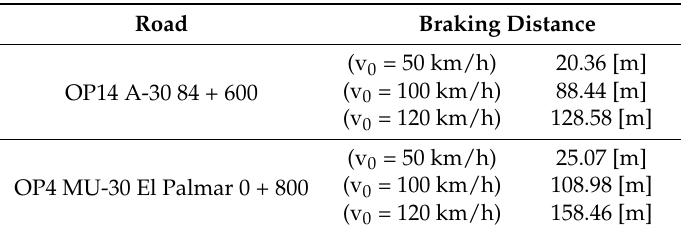
Table 8. Braking distance at different initial